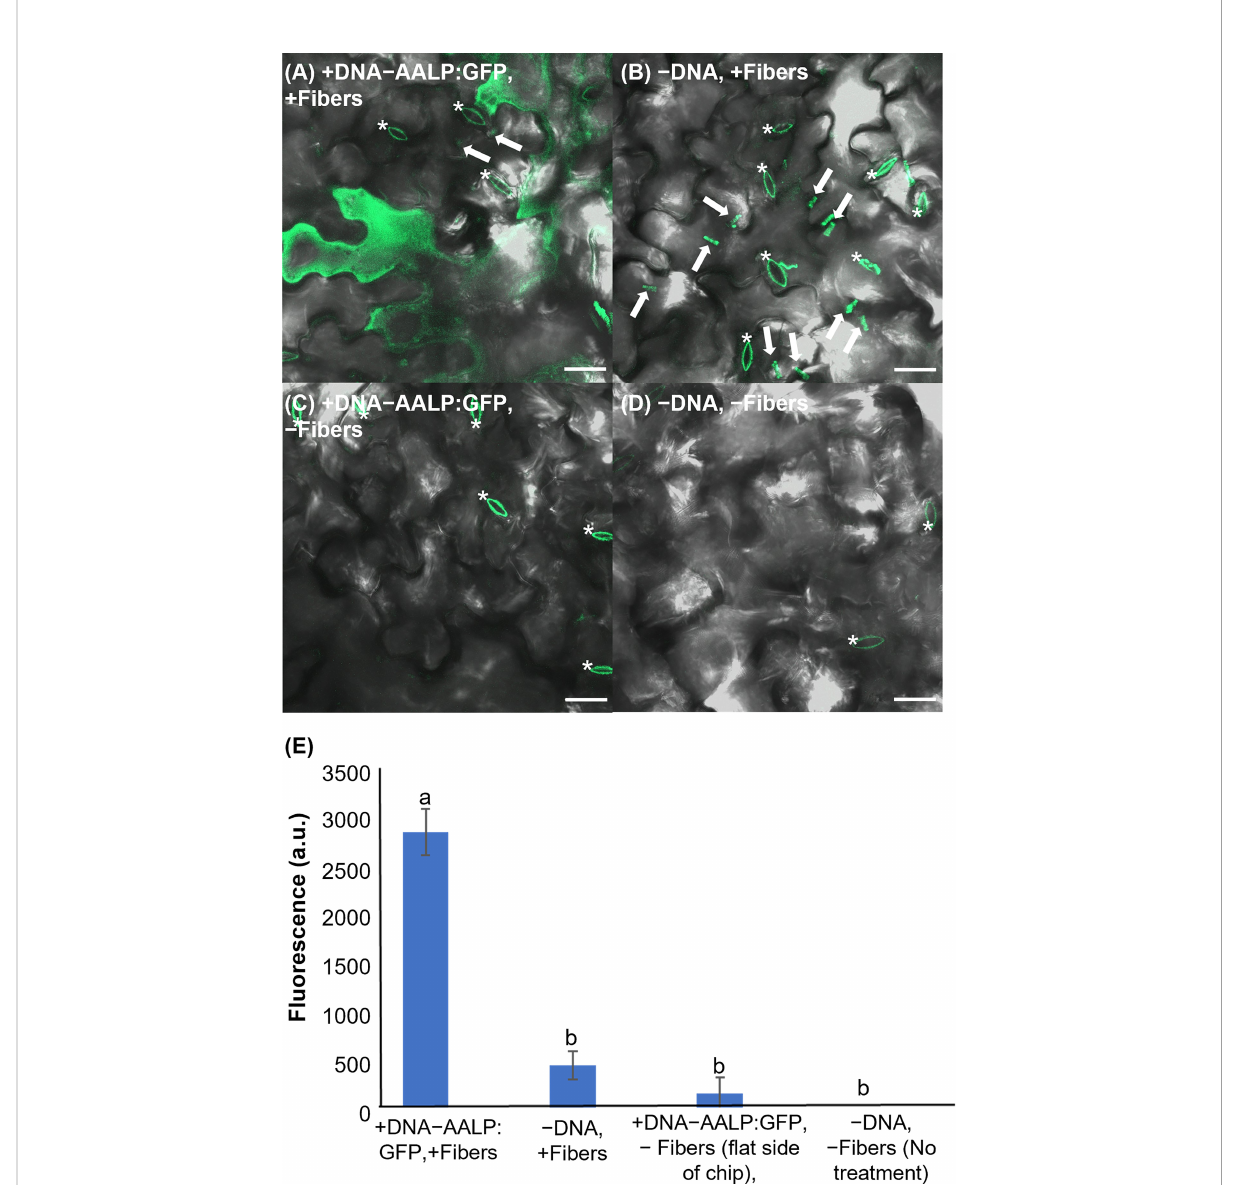
FIGURE 2 Fluorescent image analysis of Arabidopsis leaves transiently transformed with AALP:GFP 48 h after delivery via VACNF with a 35 µm pitch. (A) p35S: AALP:GFP/pUC plasmid delivery via VACNF using the on-plant method. GFP fl uorescence is shown in green (+DNA-AALP:GFP, + fi bers). (B) Fibers only ( − DNA, + fi bers). (C) AALP:GFP plasmid delivery without fi bers (backside of chip with no fi bers; +DNA-AALP:GFP, − fi bers). (D) No treatment ( − DNA, − fi bers). (E) Graph of average integrated densities of GFP fl uorescence (green channel) of de fi ned 20×20 m m areas (n ≥ 40 per condition, combined results from two experiments). Regions containing stomata (*) were excluded due to auto fl uorescence, and the average fl uorescence signal intensity from the no-treatment condition was subtracted from each average. 2-way ANOVA (and Tukey test) was used for signi fi cance testing, and error bars represent the standard error of the mean. Different letters show signi fi cant differences between treatments ( P < 0.0001). All images shown are maximum projections of 40 m m z-stacks. Scale bars are 20 m m and white arrows indicate fi bers in the